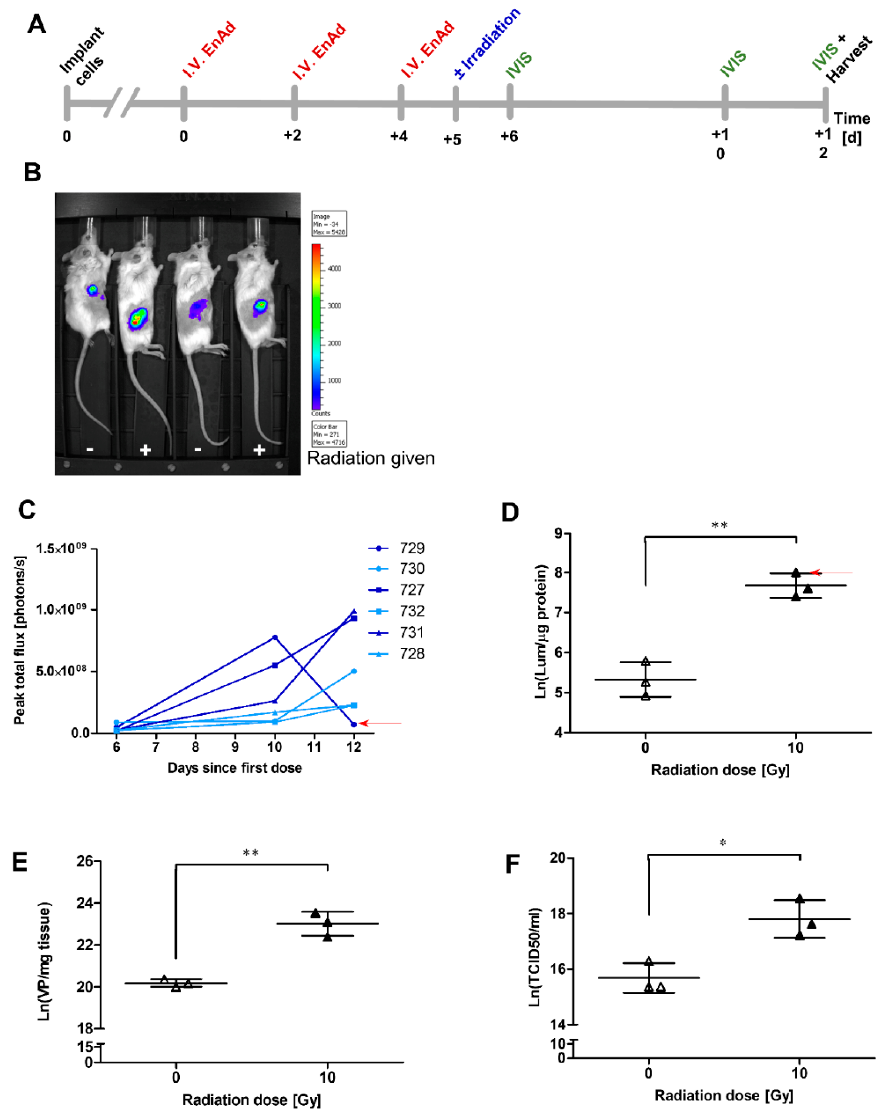
Figure 5 . HCT116 xenograft model of tumour irradiation and virus replication. HCT116 cells (2 × 10 6 cells/mouse) were implanted subcutaneously into six SCID mice. When tumours reached a volume of 50 mm 3 , all mice were given three intravenous injections of 0.5 × 10 10 virus particles EnAd-SA-FireflyLuciferase (EnAd-SA-Fluc) 48 h apart. One day after the third dose, half of the animals were randomised to receive 10 Gy of radiation to the tumour. Over the next 7 days, animal weight and tumour volume were monitored. Luciferase expression was monitored using an In Vivo Imaging System (IVIS). Mice were sacrificed and tumours were extracted at 12 days after the first virus dose for downstream analysis. ( A ) Experimental timeline. ( B ) Representative IVIS image demonstrating luminescence seen in irradiated (+) and non-irradiated ( − ) mice. Colour scale represents increasing total flux (photons/second), with blue representing a minimum of 271 p/s and red representing a maximum of 4716 p/s. ( C ) Peak total flux for all pairs of animals. Tumours were imaged at 6, 10 and 12 days after the first dose of EnAd-SA-Fluc. ( D ) Luciferase expression was measured in fresh tumour homogenate harvested immediately after sacrifice using a PolarStar Omega plate reader. ( E ) DNA was extracted from tumour homogenate to measure viral genomes by qPCR using hexon-specific primers and probe. ( F ) Viral TCID 50 /mL from tumour homogenate was evaluated using A549 cells. Data represents single animals. Significance was evaluated using logarithmic transformation to normalise data thus allowing the use of an unpaired t-test. Figures show mean ± SD; * p < 0.05, ** p < 0.01.